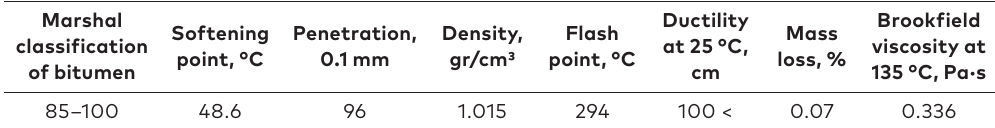
Table 1. Properties of neat